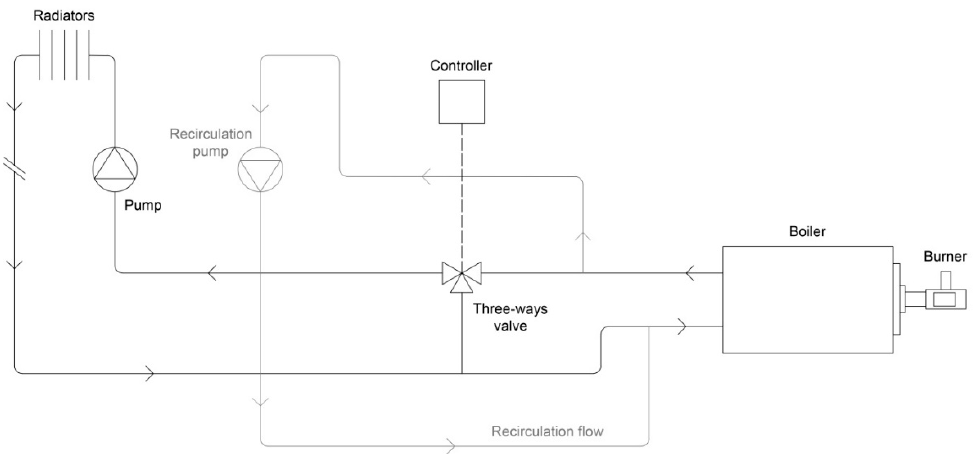
Figure 7. Heating plant scheme.